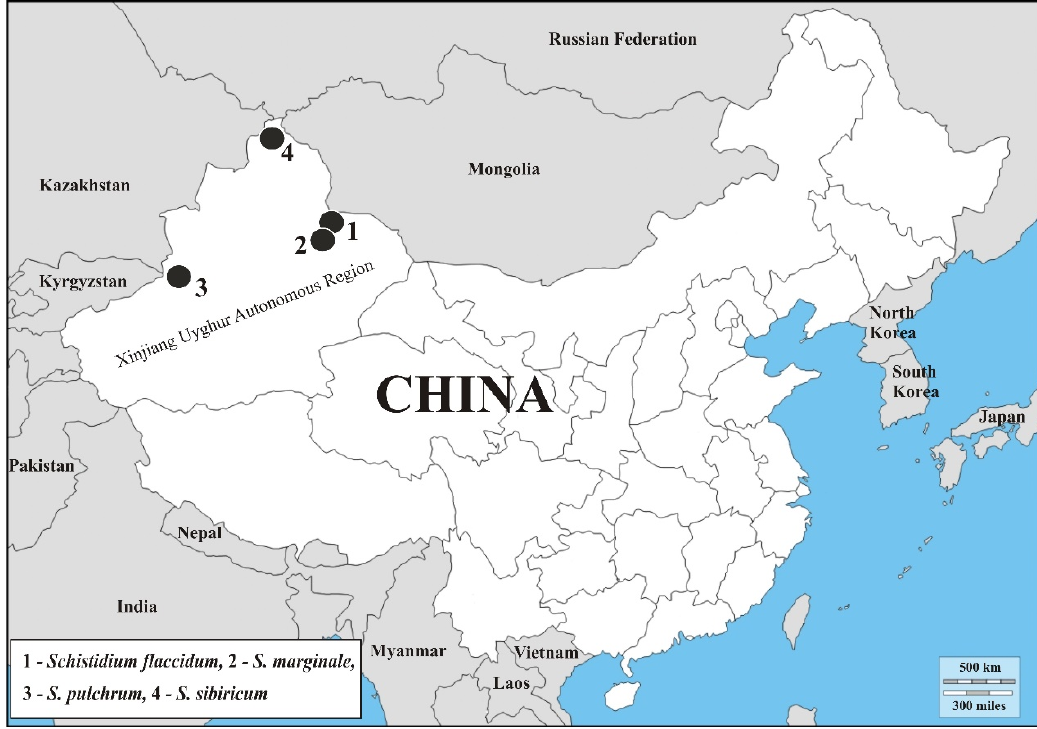
Figure 5. Map of China with distribution of newly recorded species.